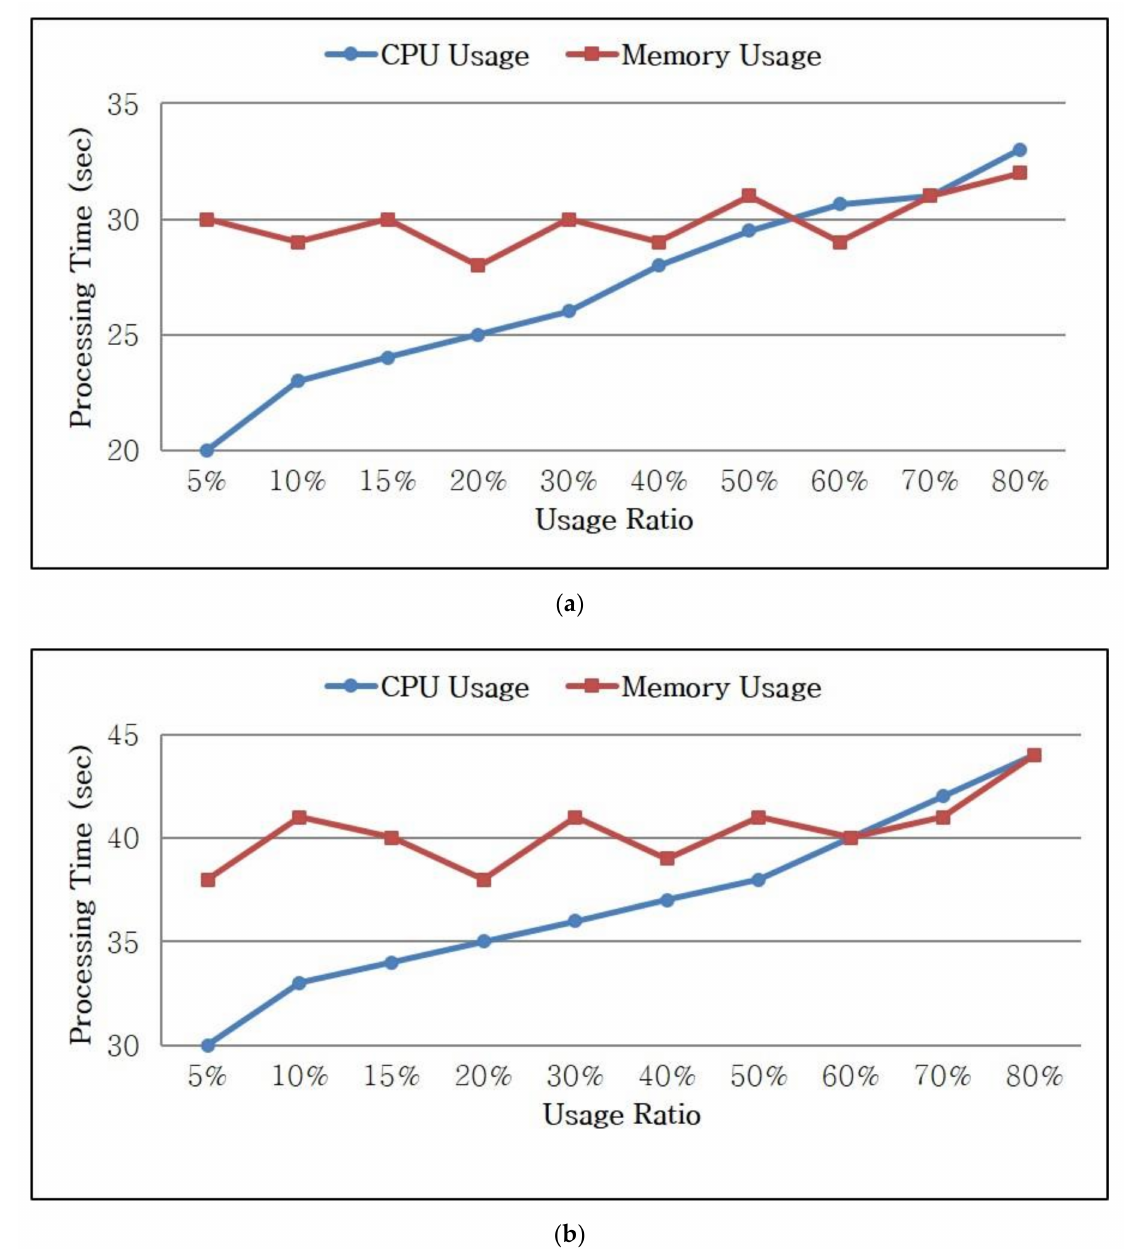
Figure 7. Processing times based on resource usage. ( a ) Processing time for simple query; ( b ) processing time for complex